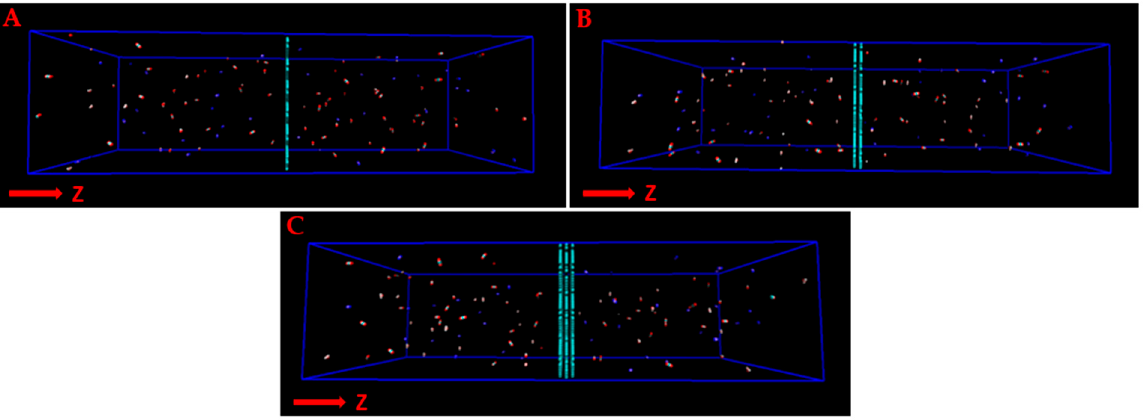
Figure 2. The simulation box, filled with a gaseous mixture of CO 2 , N 2 , and H 2 O. Single ( A ), double ( B ), and triple ( C ) layers of graphtriyne are shown.